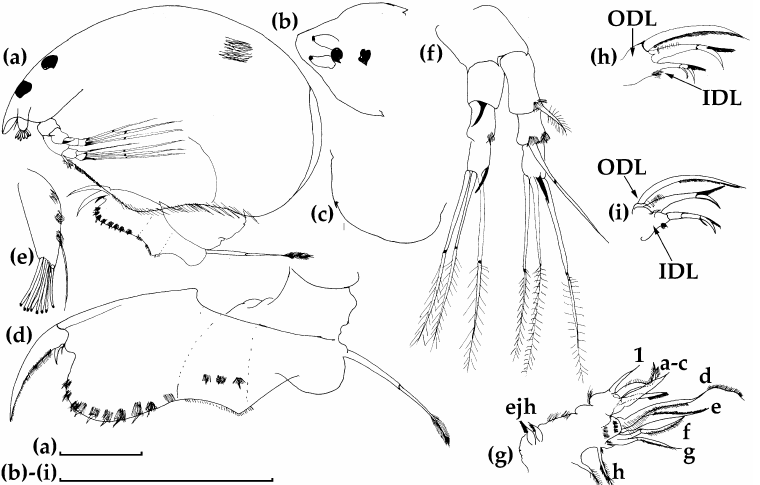
Figure 11. Anthalona mediterranea , an adult parthenogenetic female from Wadi Maidaq — Blue Pool, United Arab Emirates. ( a ) Female, lateral view; ( b ) anterior portion of head, dorsal view; ( c ) labral keel; ( d ) postabdomen; ( e ) antenna I; ( f ) antenna II; ( g – i ) thoracic limb I (schematically). All scale bars: 0.1 mm.